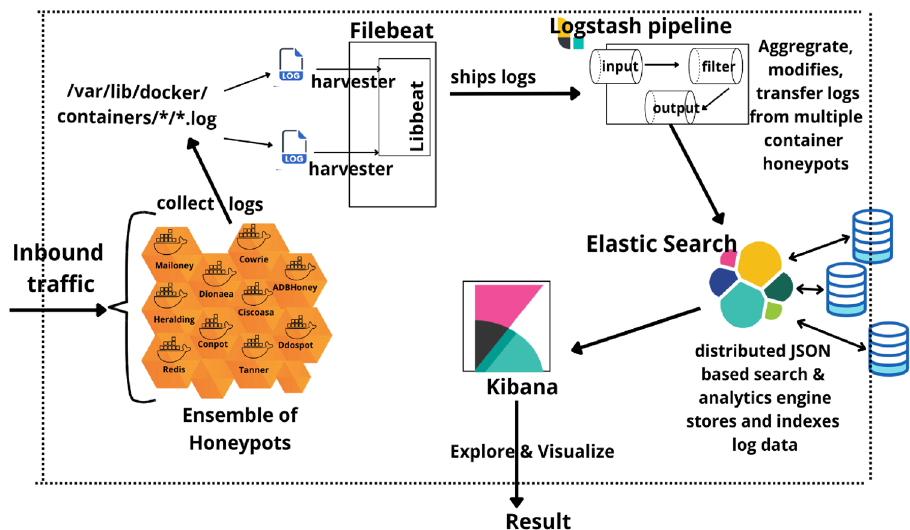
Figure 3. Collaborative operational testbed for real-time implementation using docker containerized